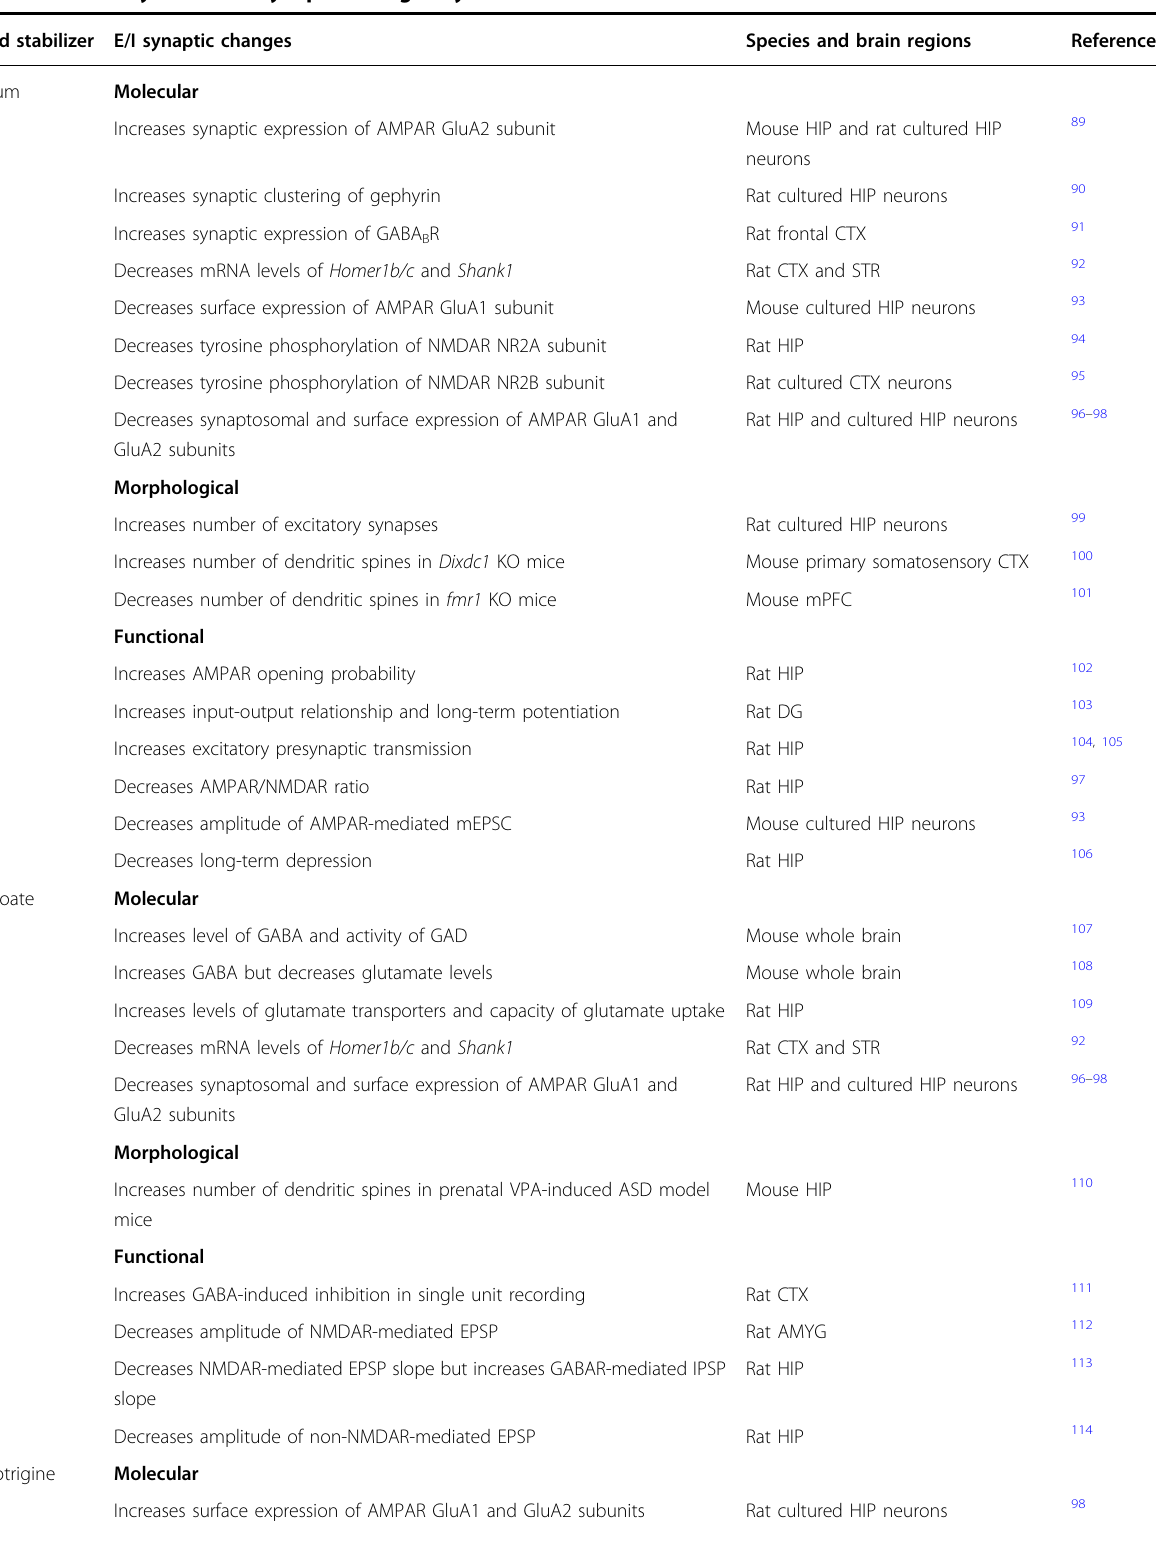
Table 1 Summary of the E/I synaptic changes by mood stabilizers Mood stabilizer E/I synaptic